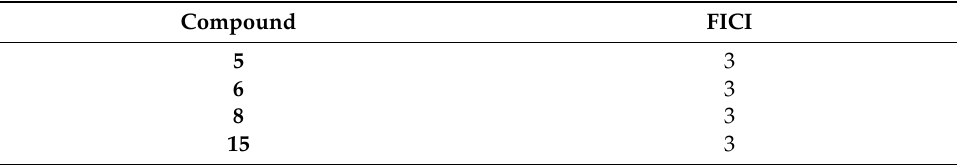
Table 3. FICI indexes of combinations of selected compounds with streptomycin.